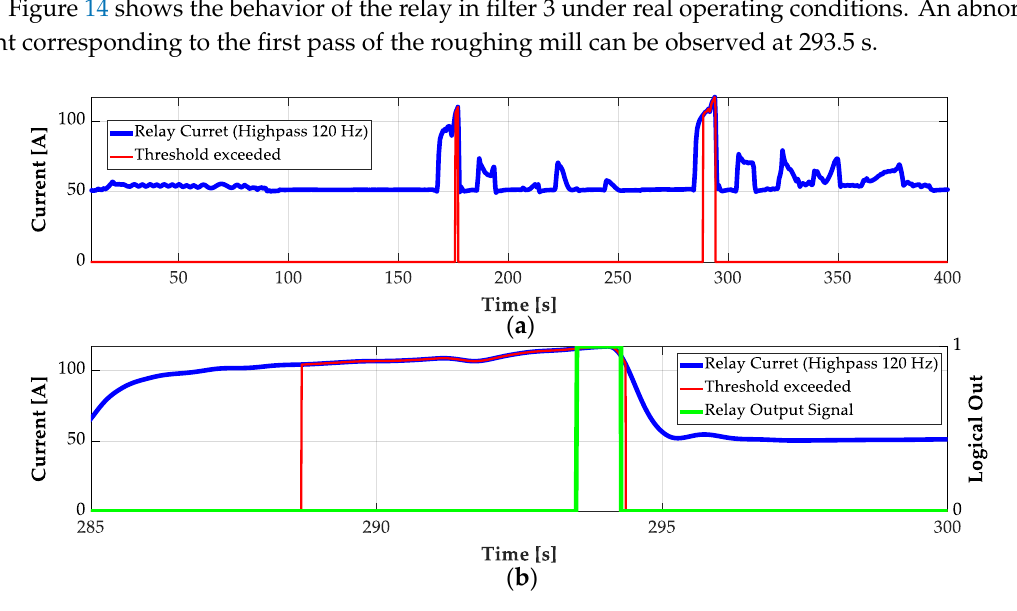
Figure 14. Filter 3 relay current: ( a ) Real operating condition; ( b ) detailed view of an abnormal event.